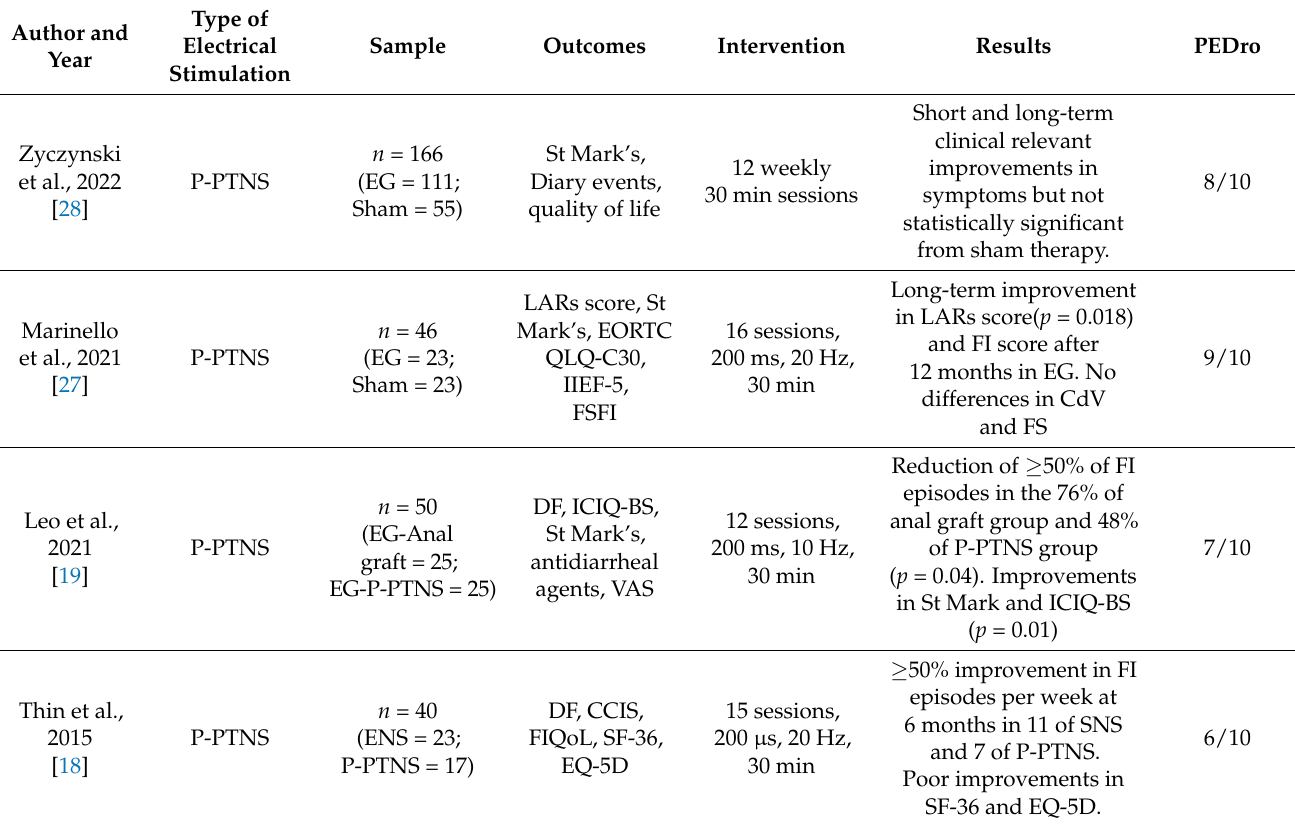
Table 2. Synthesis of the